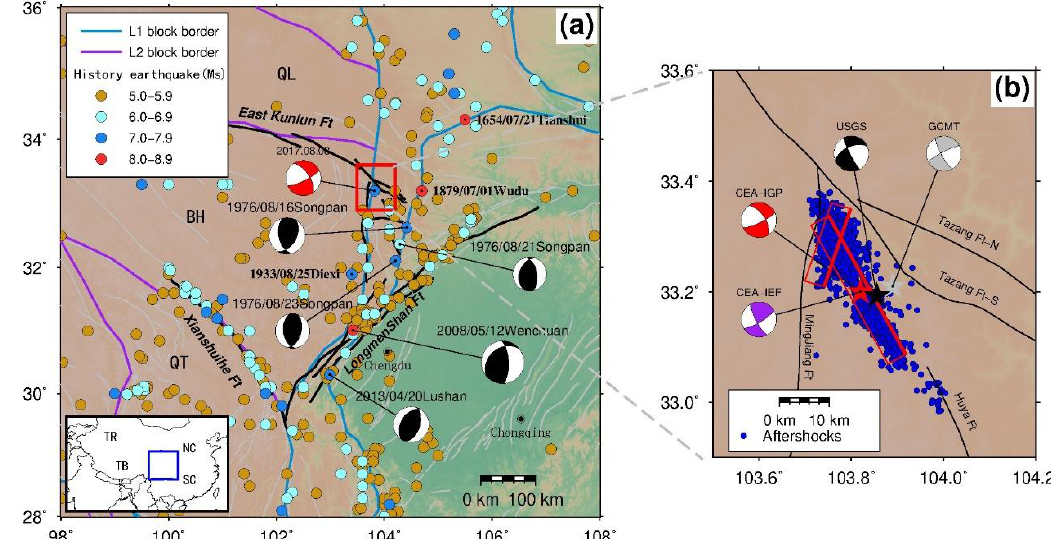
Figure 1. Tectonic setting and seismicity around the 2017 Jiuzhaigou earthquake. ( a ) Tectonic setting of the eastern margin of the Tibetan Plateau. The solid blue and purple lines indicate the primary and secondary block boundaries, respectively. The color-coded circles represent historical earthquakes (Ms ≥ 5) from the Data Sharing Infrastructure of National Earthquake Data Center (NEDC) (http://data.earthquake.cn, accessed on 14 April 2021). The black beach balls show the focal mechanisms of the historical earthquakes (Ms ≥ 6.5) in this region from the Global Centroid Moment Tensor, Harvard University Global Moment Tensor Solution (GCMT). The red beach ball represents the focal mechanism of the Jiuzhaigou earthquake from the Institute of Geophysics, China Earthquake Administration (CEA-IGP) (http://www.cea-igp.ac.cn/en/, accessed on 14 April 2021). The inset shows the large-scale tectonic environment. The red rectangle is the region shown in ( b ). Note: QT—Qiangtang block; BH—Bayan Har block; QL—Qilian block; SC—South China; NC—North China; TB—Tibet; TR—Tarim Basin. ( b ) Fault geometry and aftershocks of the Jiuzhaigou earthquake. The blue dots are the relocated aftershocks within a month from Fang et al. [6], and the red rectangle is the projection of our optimal fault model on the surface. The gray, black, red, and purple beach balls show the focal mechanisms determined by the GCMT, United States Geological Survey (USGS) (https://www.usgs.gov/, accessed on 14 April 2021), CEA-IGP, and Institute of Earthquake Forecasting, China Earthquake Administration (CEA-IEF) (http://www.ief.ac.cn/, accessed on 14 April 2021), respectively. Table 1. Focal mechanisms of the 2017 Jiuzhaigou earthquake determined by different institutions. Nodal Plane I Nodal Plane II Magnitude (Mw) Depth (km) Strike, Dip, Rake Strike, Dip,